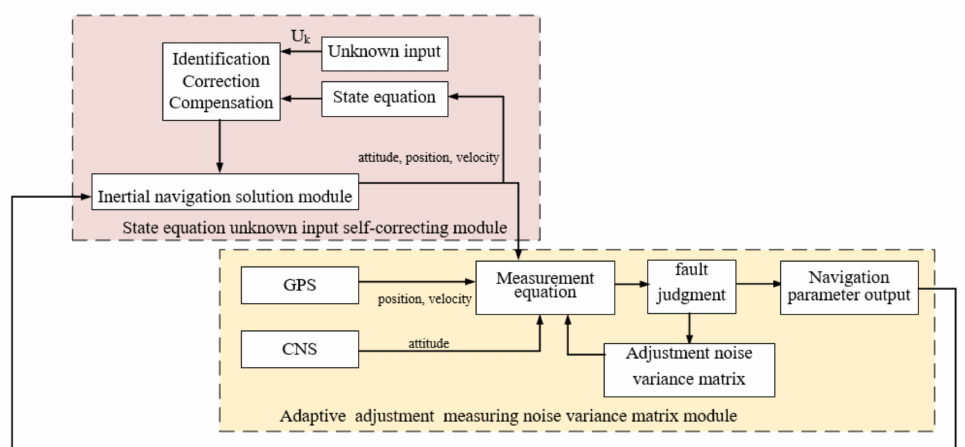
Figure 3. Multi-layer robust and fault-tolerant filter design